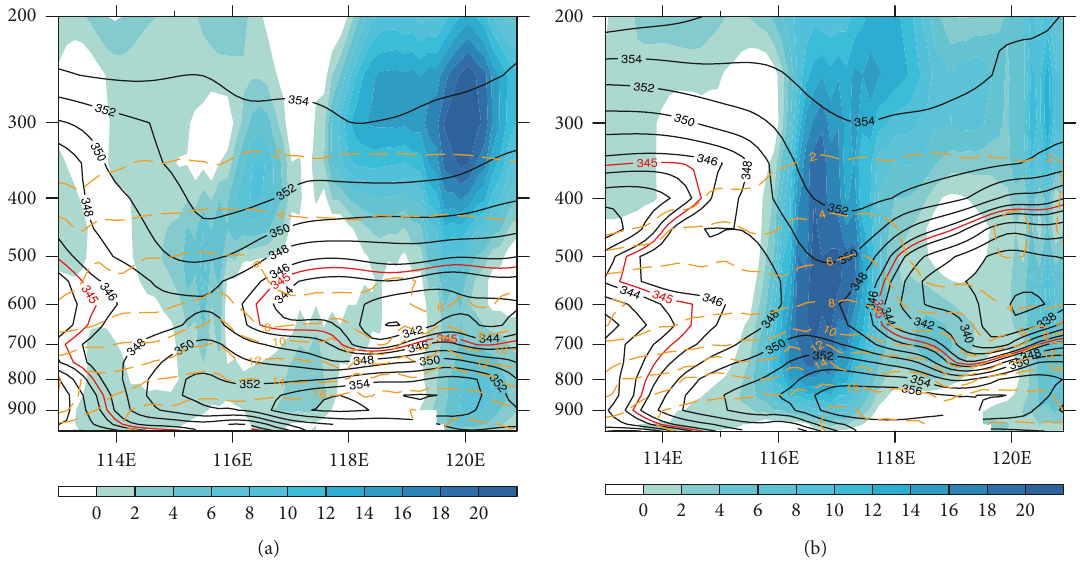
Figure 9: Vertical cross sections along 31 ° N of equivalent potential temperature black solid lines, unit: K; the red solid lines are isolines of 345K, specific humidity (orange dashed lines, unit: g July. Y -axis is pressure (unit: